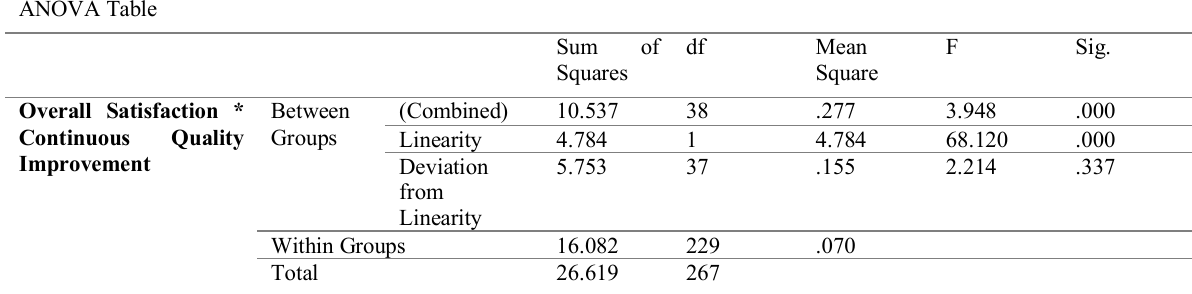
Table 11: Linearity test for continuous quality improvement and patients’ satisfaction